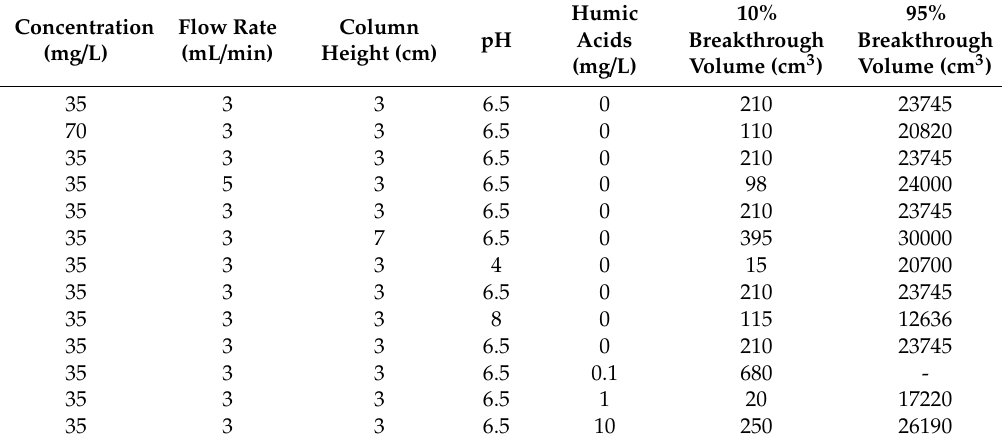
Table 1. Comparative data of penetration curves of dynamic coke adsorption sulfamethoxazole dynamic column experiments.